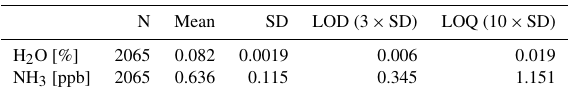
P10) MPV (C25-61800, VICI Valco Inst. Co. Inc., Texas, Table 2. Limit of detection and limit of quantification from a 1h stable measurements on zero